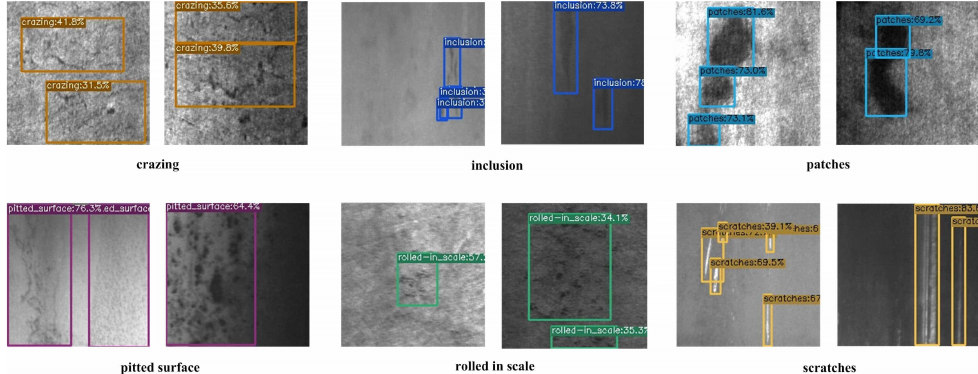
Figure 13. Visualization results of YOLOX-S 1 on the NEU-CLS